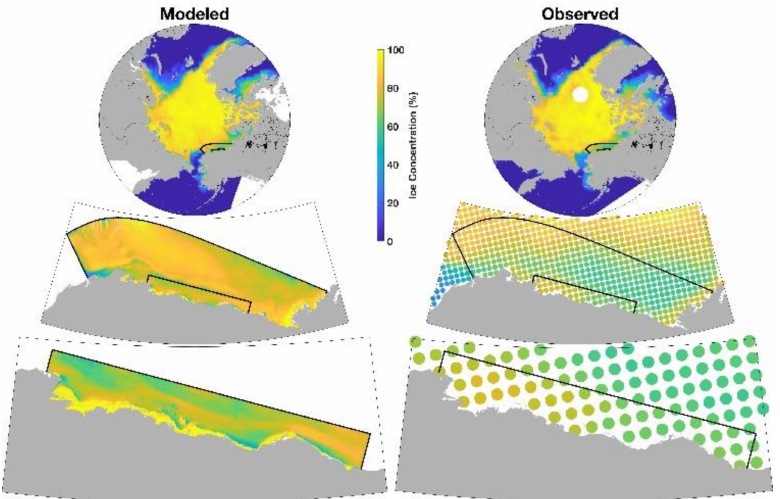
Figure 6. Comparison of modelled (left) and observed (right) ice concentration for the coarse resolution (top), medium-resolution (middle) and fine-resolution (bottom) models (from [119]). Lu et al. (2020) [121] used an idealized ROMS simulation for a portion of the Chukchi Sea called the Central Channel. They used a series of analyses to investigate the effects on ice ablation of wind, atmospheric fluxes, and the heat and mass flux of Bering Strait flow. These analyses resulted in an organized understanding of how these factors affect ice